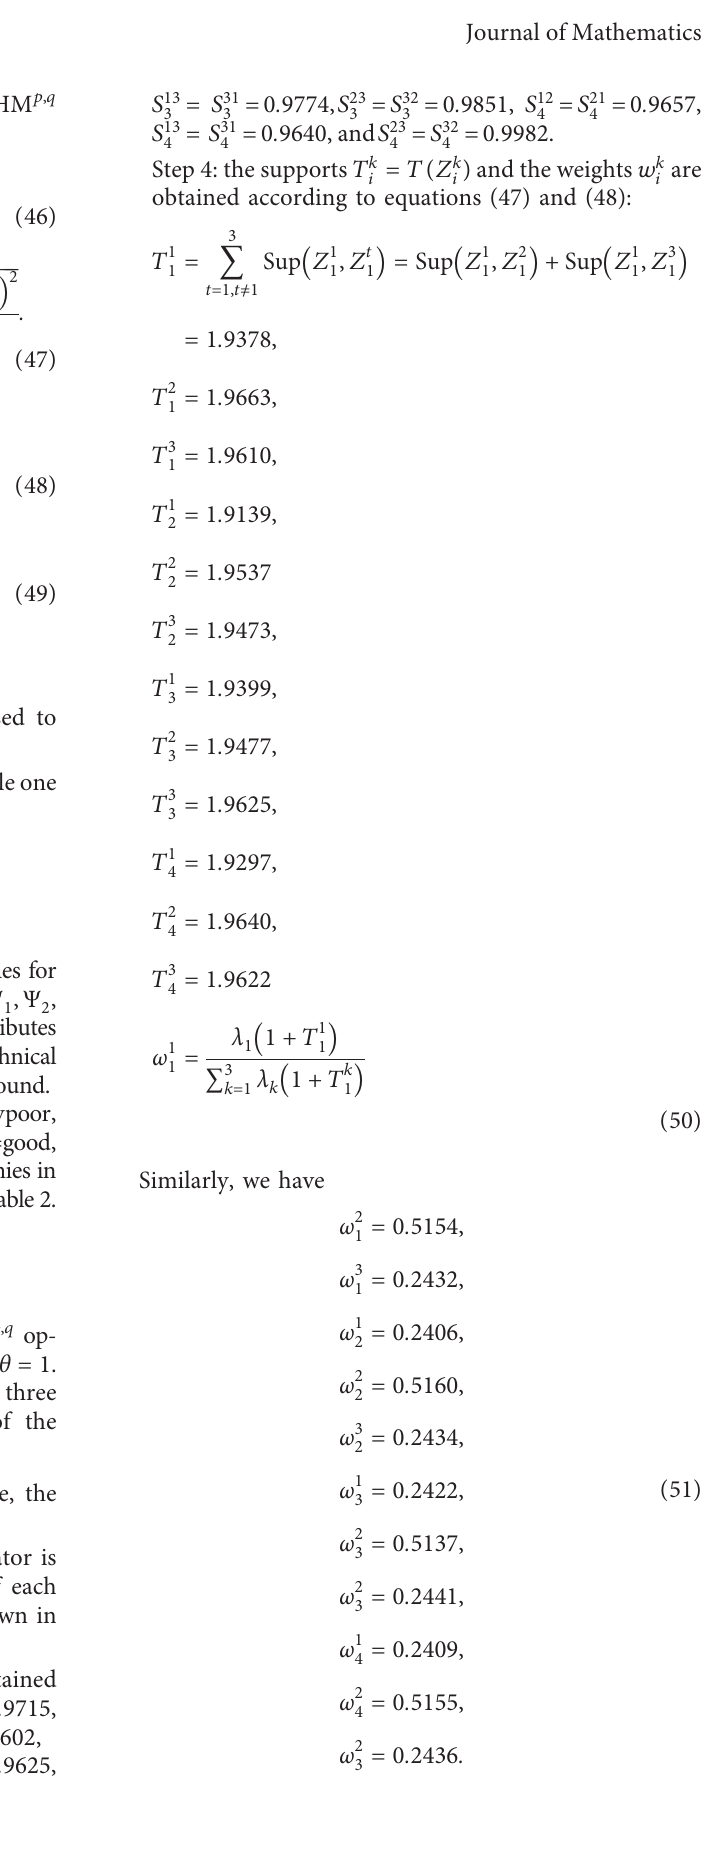
Step 3: the supports S kt according to equation